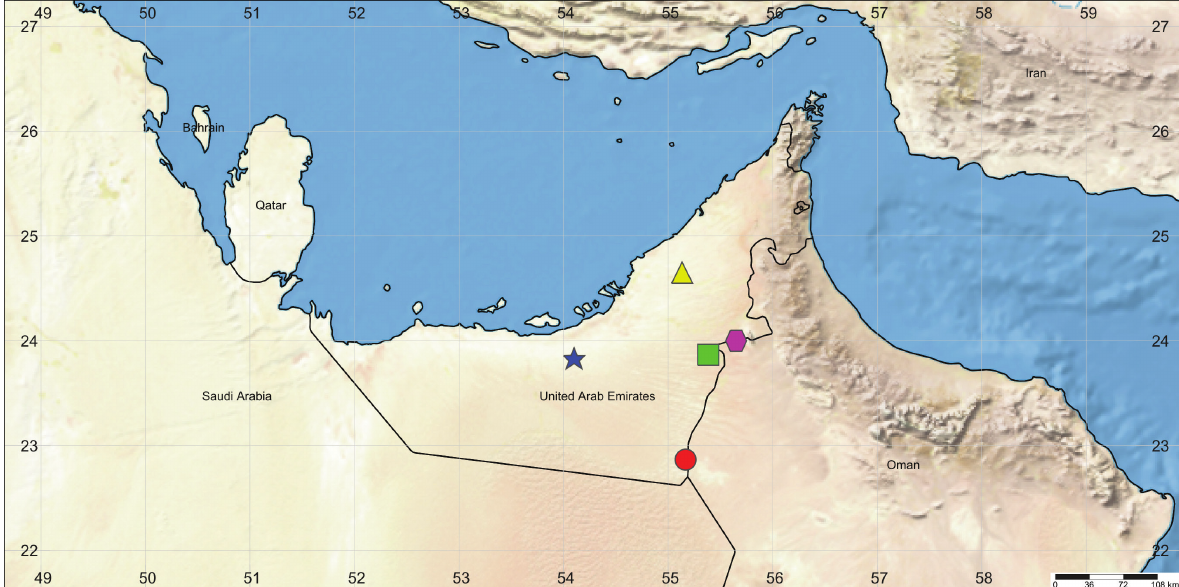
Figure 7. Map of collection localities of Pterotricha spp. in the United Arab Emirates. Circle: Umm al Zumul; Star: Madinat Zayed; Square: Khatam; Triangle: Public Hunting Triangle; Hexagon: